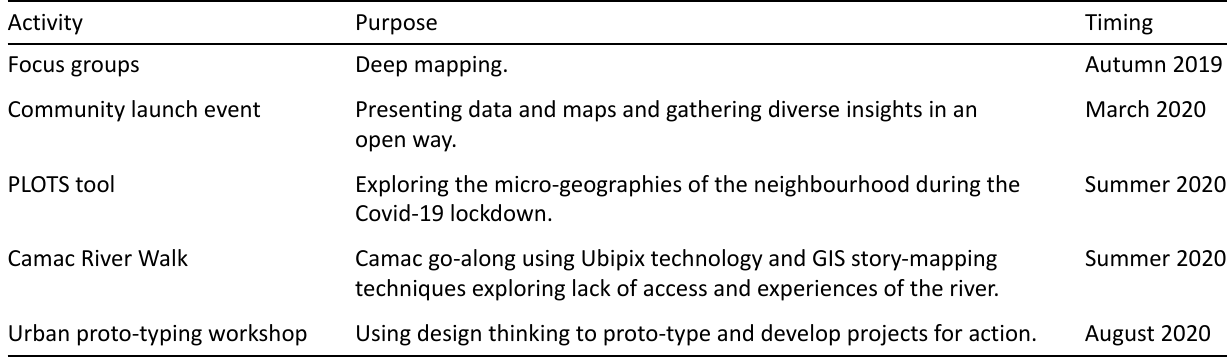
Figure 3. Phases of the co‐creation process. Table 3. MGD co‐creation activities and